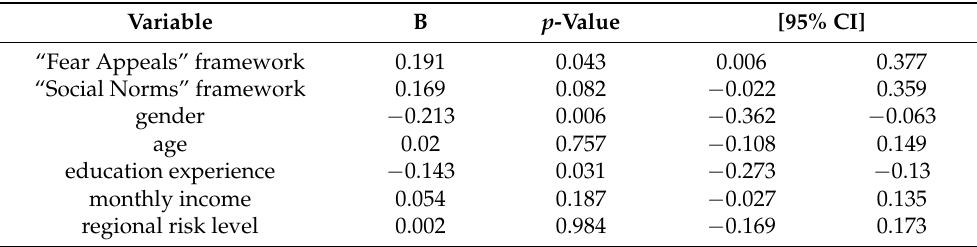
Table 1. Linear regression model of vaccination recommendation on risk communication frameworks, n = 165.